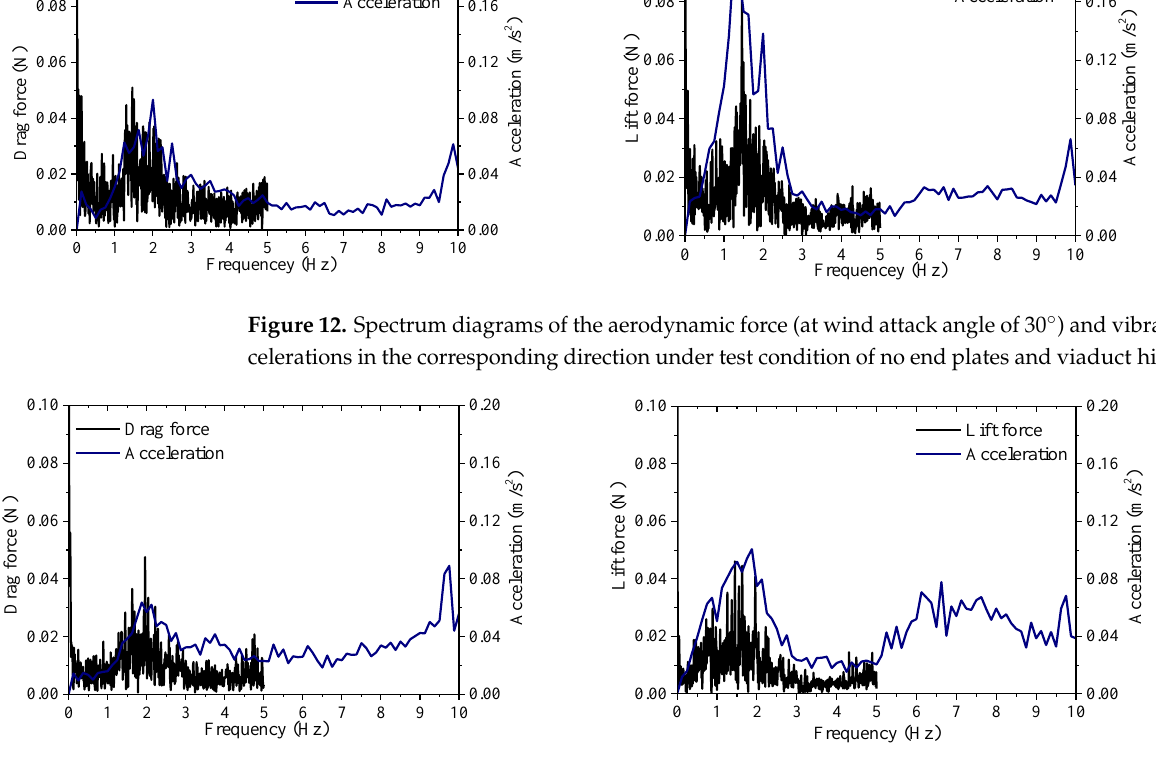
Figure 13. Spectrum diagrams of the aerodynamic force (at wind attack angle of 30°) and vibration accelerations in the corresponding direction under test condition of no end plates and tunnel highway.